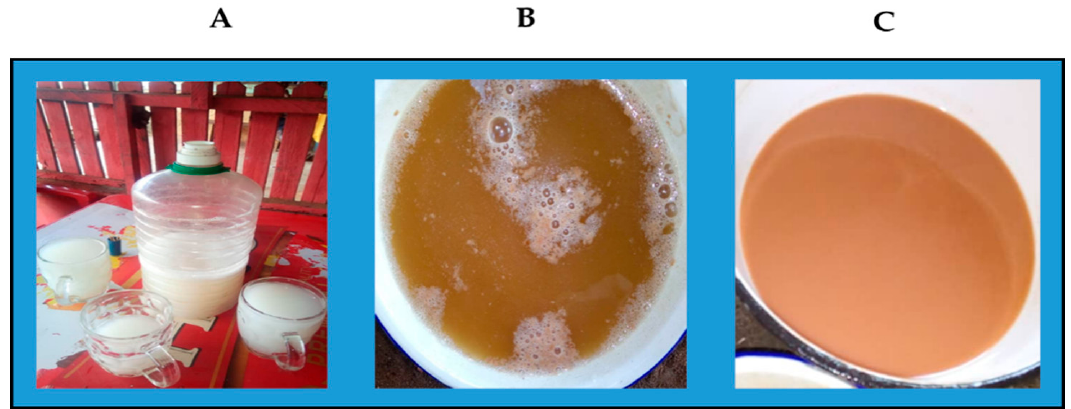
Figure 3. Three main artisanal alcoholic beverages sold in Nigeria. Palm wine ( A ), pito ( B ) and